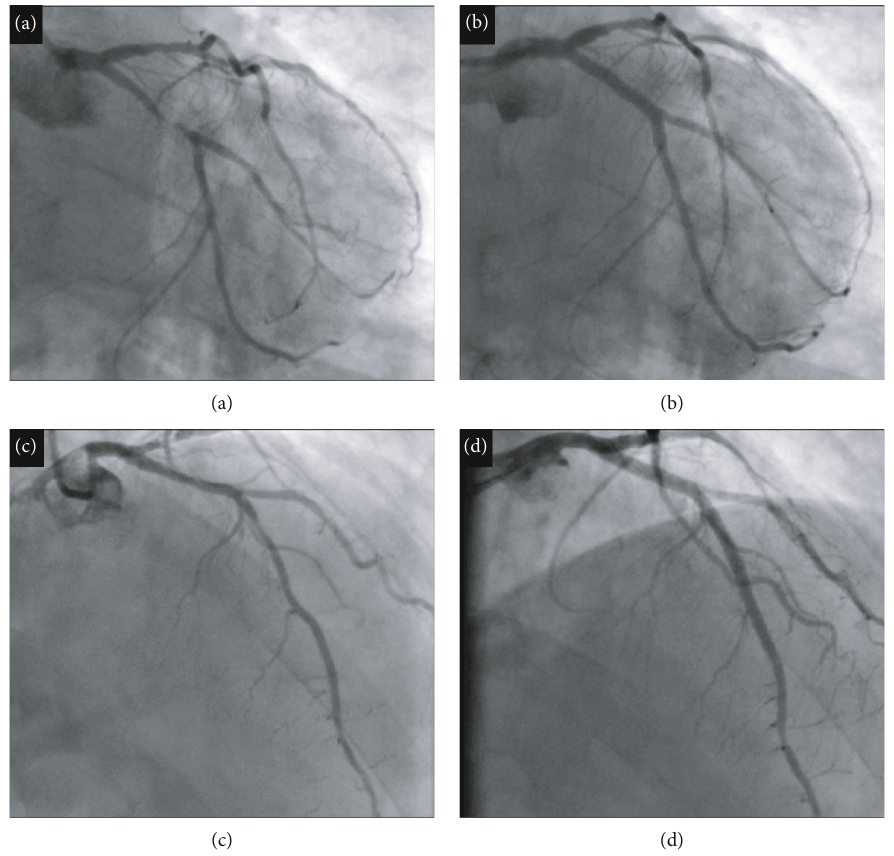
Figure 1: The angiogram shows 2-vessel CAD (coronary artery disease) with subocclusion of the proximal circum fl ex coronary artery (LCx) (a) and critical stenosis of the proximal and middle anterior descending coronary artery (LAD) (c). Good fi nal result after PCI with implantation of a DES (drug-eluting stent) in the proximal-middle LCx at the bifurcation with the MO1 branch (b) and two contiguous DES on the proximal-middle LAD (d).